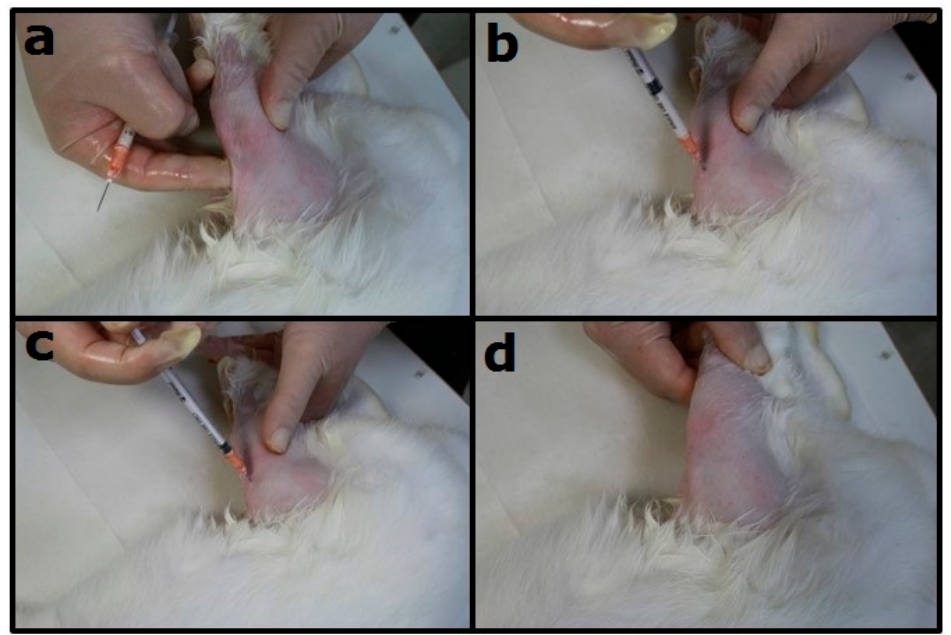
Figure 2. Knee injection with biodegradable microparticles to a New Zealand white rabbit. ( a ) The surgical site was shaved and the aseptic procedure was performed at the injection site; ( b ) the supra- patella pouch of the knee joint of rabbit was identified and penetrated with a needle; ( c ) 1 mL phosphate-buffered solution (PBS) + 200 mg drug-loaded nano/microparticles was injected; ( d ) free range of motion after injection was confirmed.